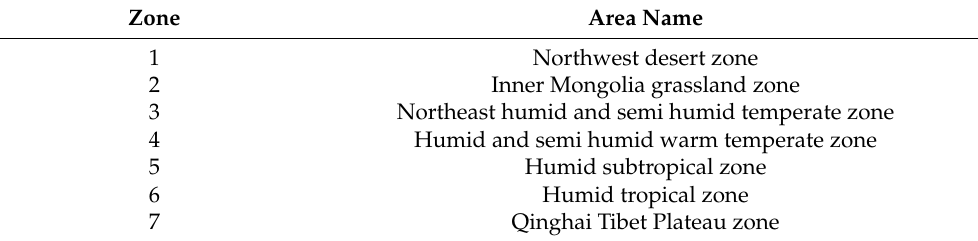
Figure 1. Climate zones of China and geographical distribution of 689 meteorological stations. (See Table 1 for the names of climatic zones 1–7). Table 1. Names of the seven climate zones.